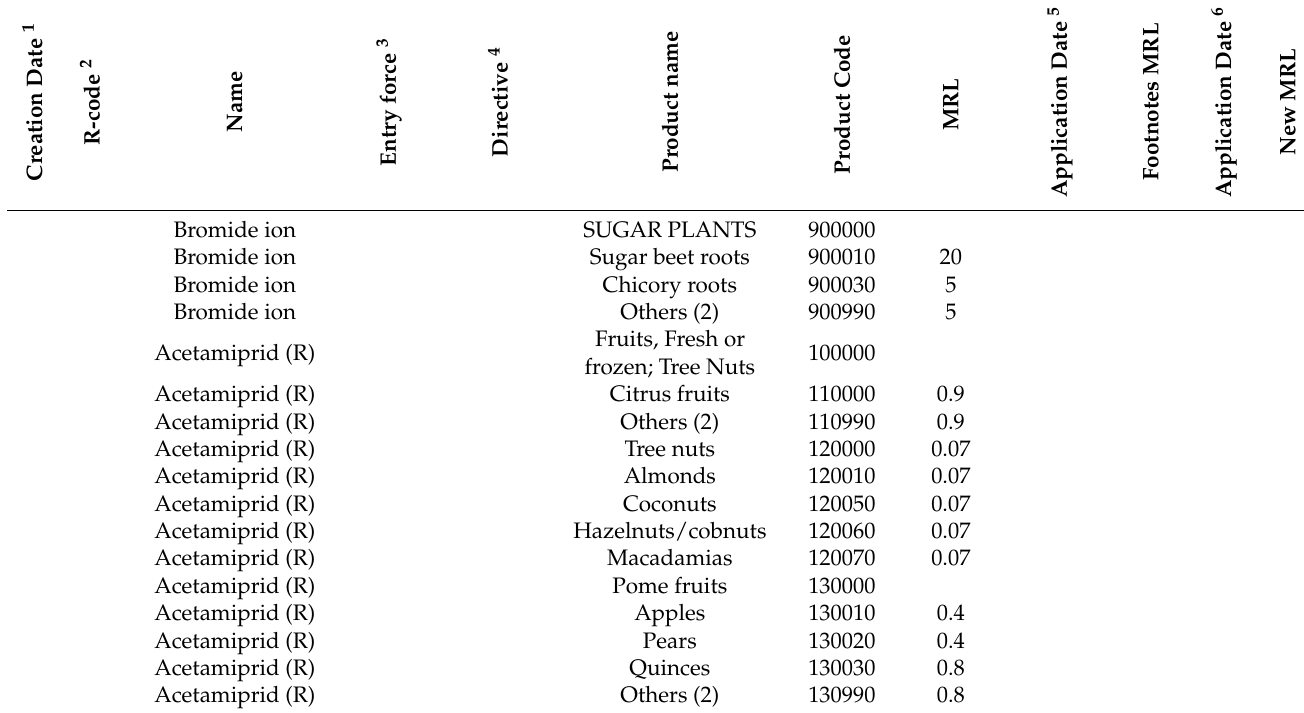
Table A2. Example for the active substance code dictionary (condensed for presentation).